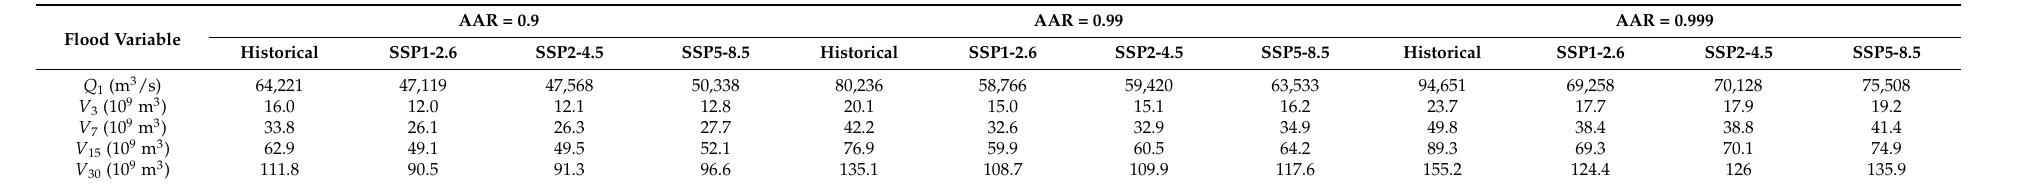
Table 7. Univariate dam-site design floods for the